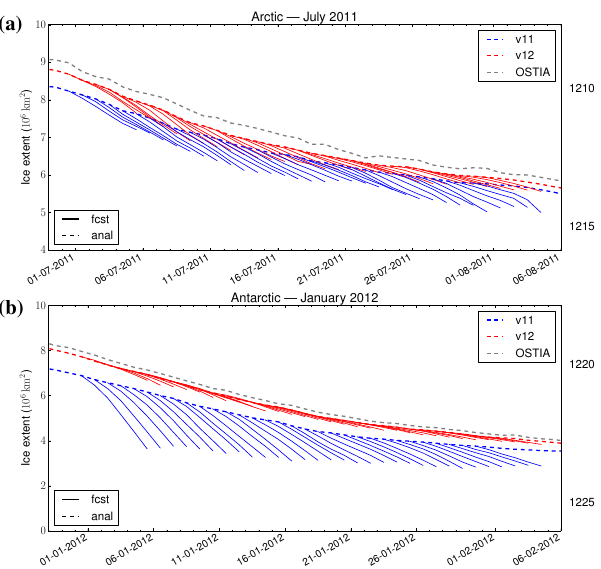
Figure 8. Time series of (a) Arctic sea ice extent (10 6 km 2 ) for the forecasts performed in July 2011 and (b) Antarctic sea ice ex- Fig. 8. Time series of (a) Arctic sea ice extent ( 10 6 km 2 ) for the tent (10 6 km 2 ) for the forecasts performed in January 2012 from forecasts performed in July 2011 and (b) Antarctic sea ice extent the v12 (red), v11 (blue) and OSTIA (grey) systems. Dashed lines ( 10 6 km 2 ) for the forecasts performed in January 2012 from the v12 show extents calculated from analysis ice concentration fields, re- (red), v11 (blue) and OSTIA (grey) systems. Dashed lines show ex- drawn from Fig. 4, whilst solid lines show the evolution of the ice tents calculated from analysis ice concentration fields, redrawn from extent over each of the 5-day hindcasts performed during the 31-day Fig 4, whilst solid lines show the evolution of the ice extent over each of the 5-day hindcasts performed during the 31 day periods.